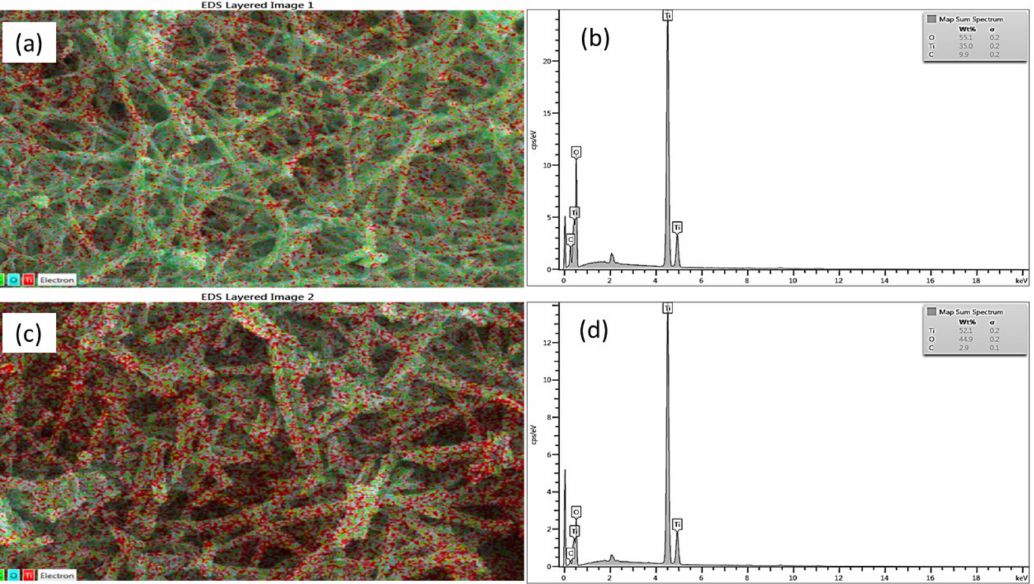
Figure 2. ( a ) Mapping of elements on PAN/TiO 2 nanofibers; ( b ) EDX spectra of PAN/TiO 2 nanofibers; ( c ) Mapping of elements on THN after calcination; ( d ) EDX spectra of THN after